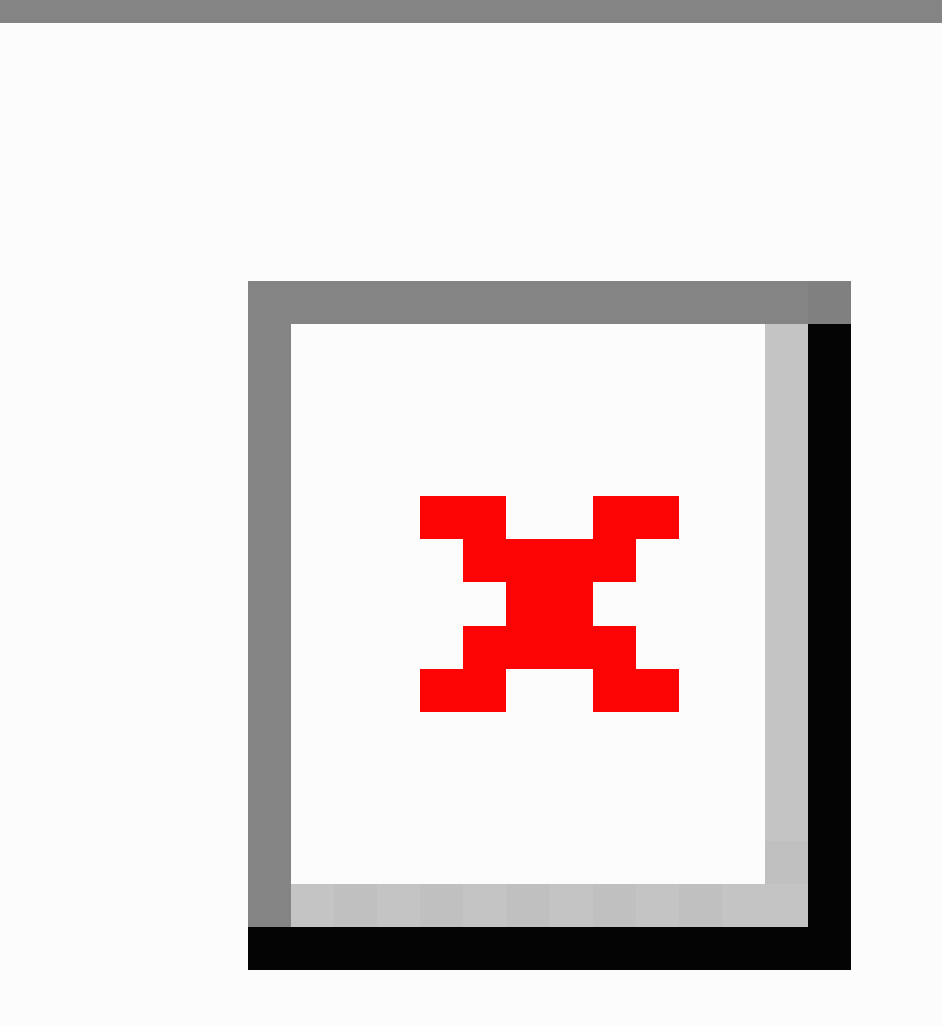
Figure 4. Automatically structured text that corresponds to our example document (Figure 1). When compared with the reference standard, added text is shown as bold and removed text is shown in grey. Risk-carrying errors include: (1) "chest pain" moving from "MY SHIFT, Status" to "PATIENT INTRODUCTION, Disease/problem history", (2) not identifying "tachycardic" and "scoring MEWS of 3 for the tachycardia" for "MY SHIFT, Other Observation", (3) not identifying "echo" for "APPOINTMENTS, Description", and (5) not identifying "anginine" and "new meds" for "MEDICATION, Medicine". RN: registered nurse and IE: information